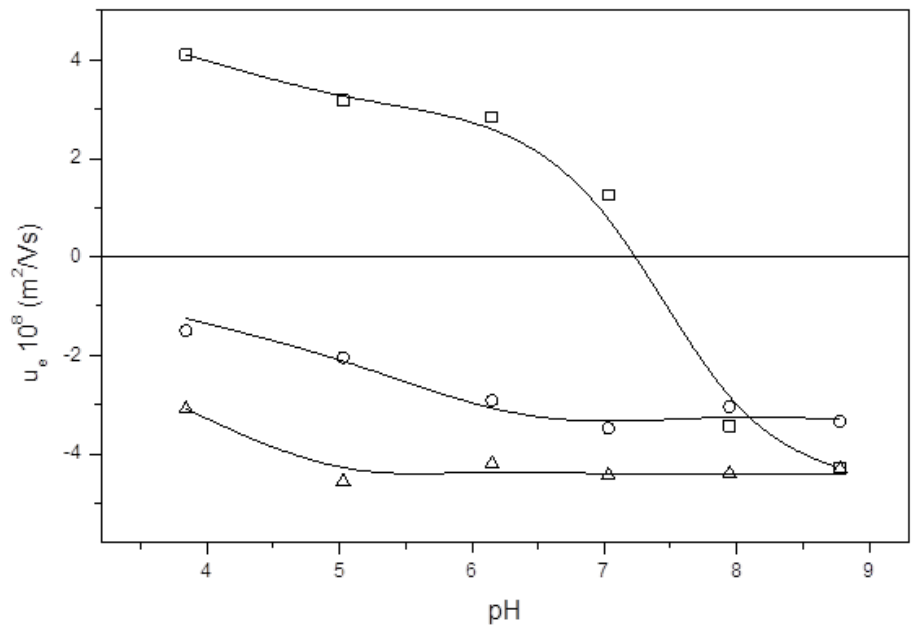
Figure 3. Electrophoretic mobility vs. pH for (∆) EPI; (□) CS; and (○) PhS